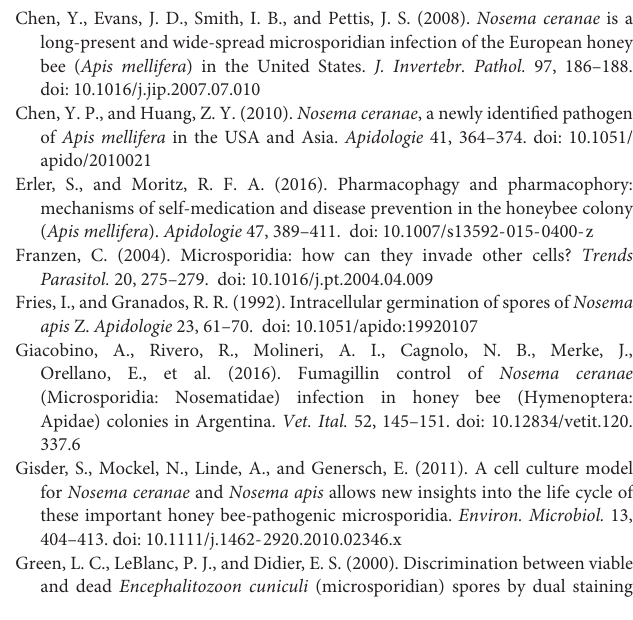
FIGURE S1 | Identification of Nosema ceranae spores. (A) Microscopic view of purified N. ceranae spores used in this study. (B) Gel electrophoresis of PCR products from spore samples using primers for N. ceranae , N. apis , and β -actin. Samples 1 and 2 were collected at the beginning and end of this study, respectively. Microscopy and PCR results indicate that spore preparations consist of N. ceranae . FIGURE S2 | Treatment solutions consumed by bees in 24 h. Individual bees were housed in feeding chambers with feeders containing treatment solutions attached to chambers. Feeders were weighed before and after 24-h feeding periods. After controlling for evaporation, final weights were subtracted from initial weights in order to calculate the mass of food consumer per 24 h. Volumes consumed per bee were then determined according to the calculated density of known sample volumes and weights. All treatments were stained with blue food dye and animals dissected to confirm that bees had ingested treatment solutions. Each bar represents the mean ± SEM (n.s., not statistically different; n =